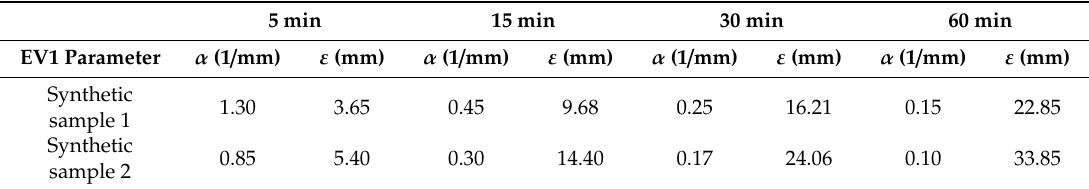
Table 3. EV1 parameters for two synthetic samples analyzed in the validation step.